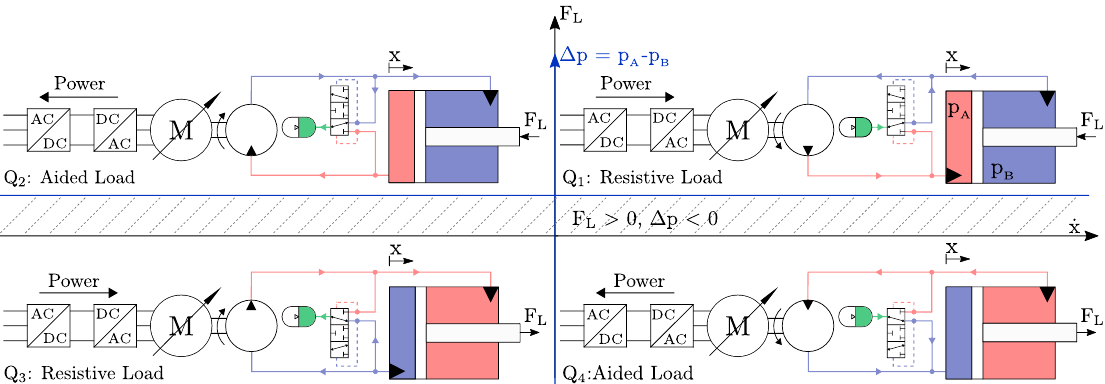
Figure 3. Four-quadrant operation of a pump-controlled differential cylinder drive. This particular architecture consists of a variable-speed electric motor connected to a fixed-displacement pump. The uneven cylinder chamber flow is compensated by a so-called inverse shuttle valve